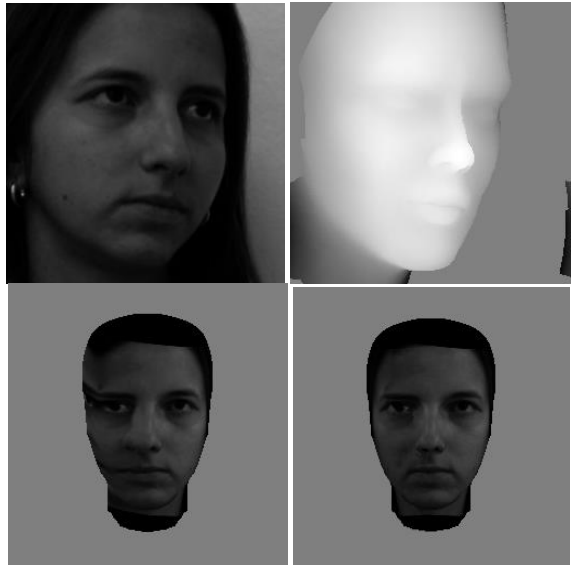
Figure 8. Textured 3D models of human and mannequin faces in frontal and non-frontal